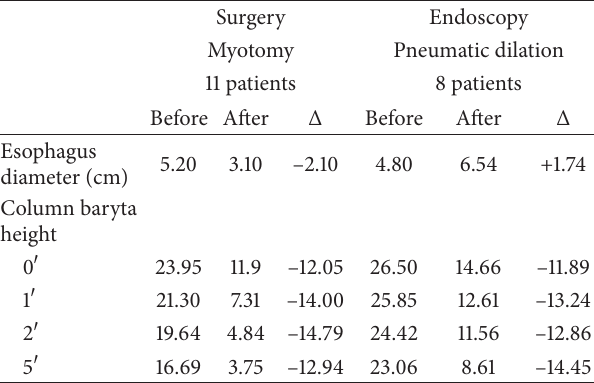
Table 1: Table shows the variation of esophageal diameter and the height of barium column before and after surgical or endoscopic treatment at 0, 1, 2, and 5 minutes after barium administration.